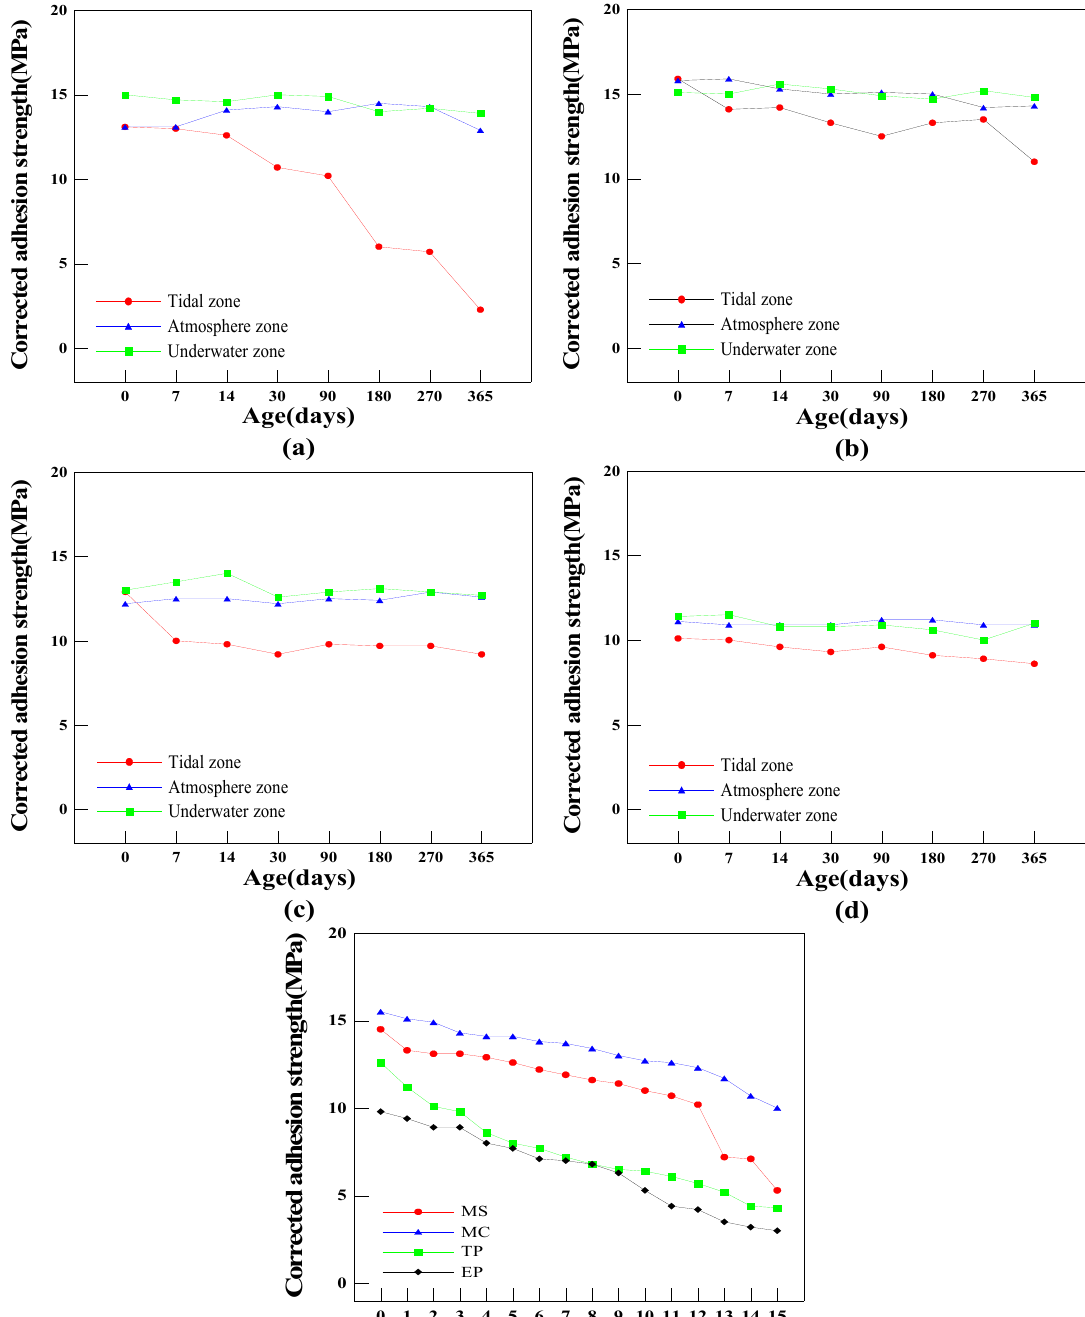
Figure 4. Corrected adhesion strength of ( a ) MS, ( b ) MC, ( c ) TP, ( d ) EP and corrected adhesion strength of coating systems after salt spray test ( e ).